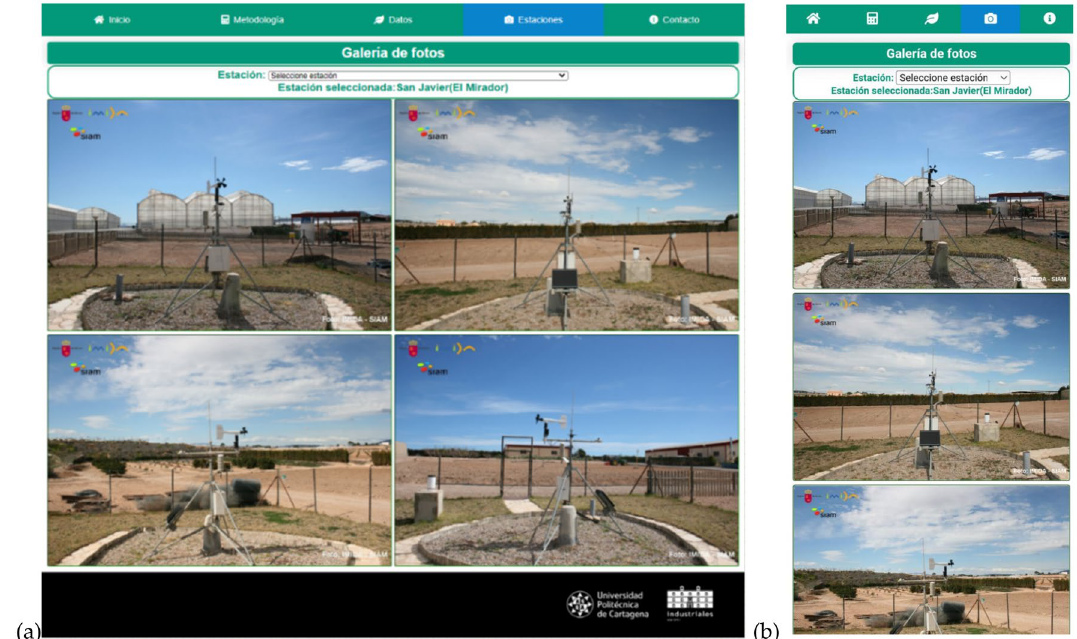
Figure 8. View of the Stations page in ( a ) the web application and ( b ) the mobile